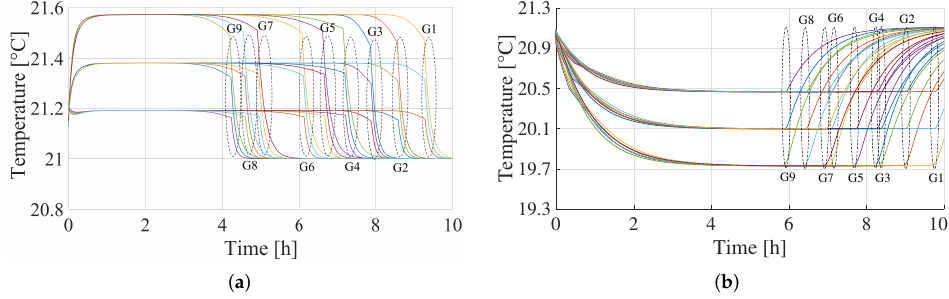
Figure 10. Temperature as a function of time: ( a ) Absorption process, ( b ) Desorption process.